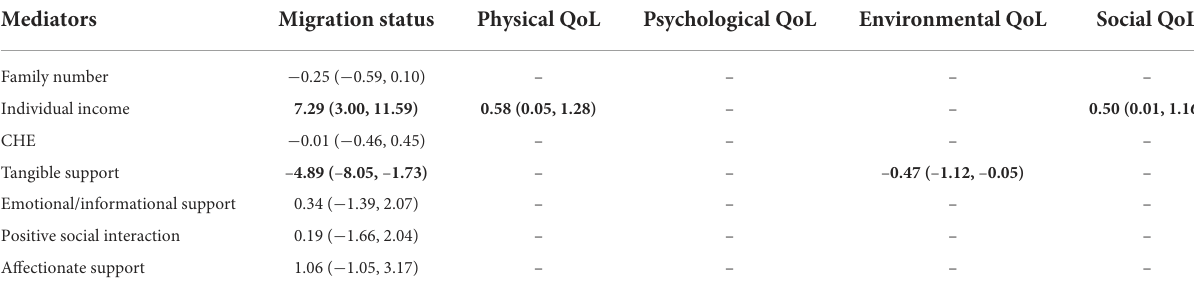
TABLE 4 Indirect effects of migration on the four dimensions of QoL for rural adults with rare diseases.